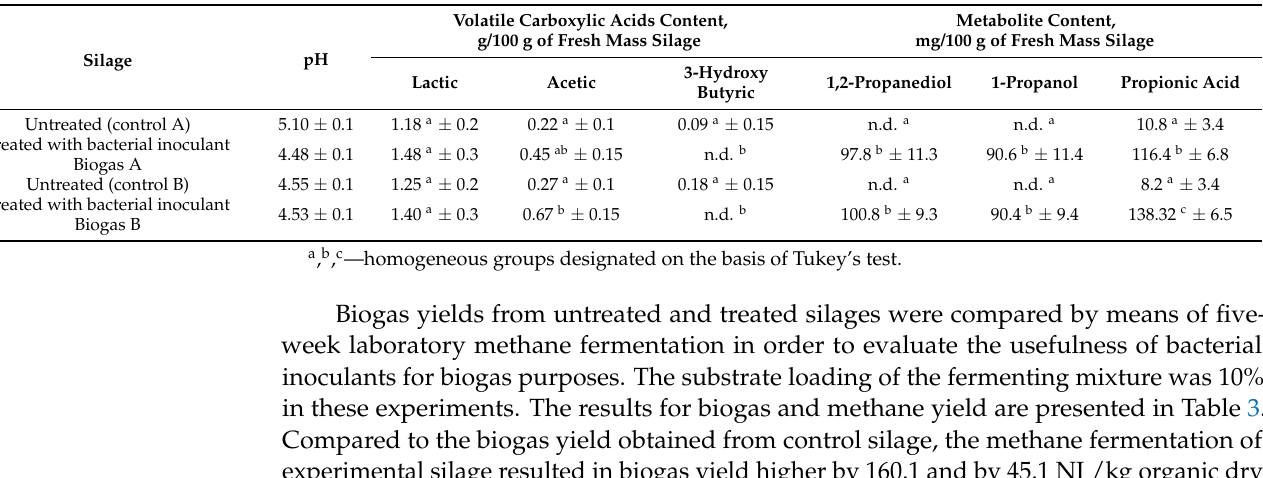
Table 2. The content of organic acids, 1,2-propanediol and 1-propanol in grass silages, prepared with and without the addition of the bacterial inoculant Biogas A consisted of L. buchneri KKP 2047p and L. diolivorans KKP 2057p or bacterial inoculant Biogas B consisted of L. buchneri KKP 2047p and P. acidilactici KKP 2065p. There was showed a standard deviation for each measurement (after the symbol “ ± ”), n.d.—not detected.